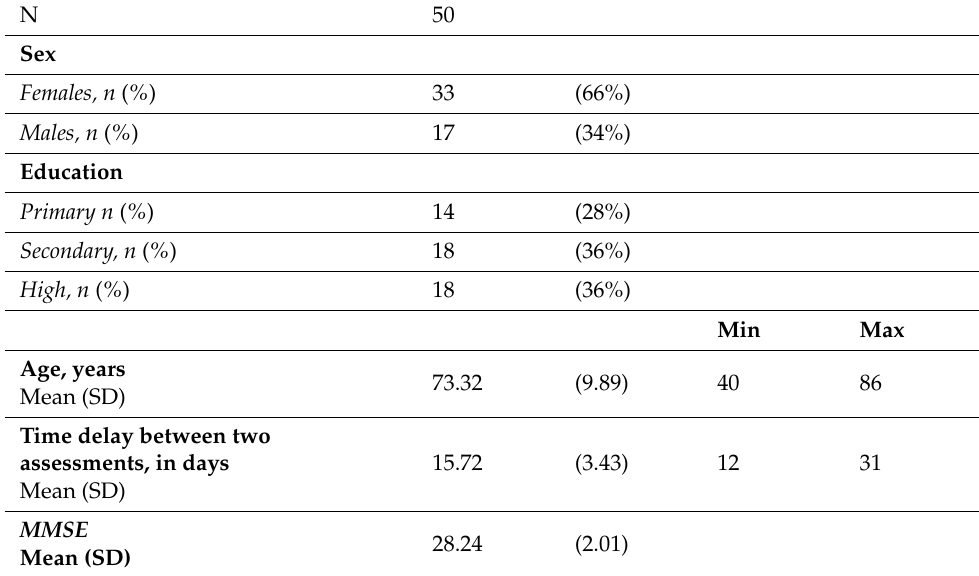
Table 2. Socio-demographic characteristics.